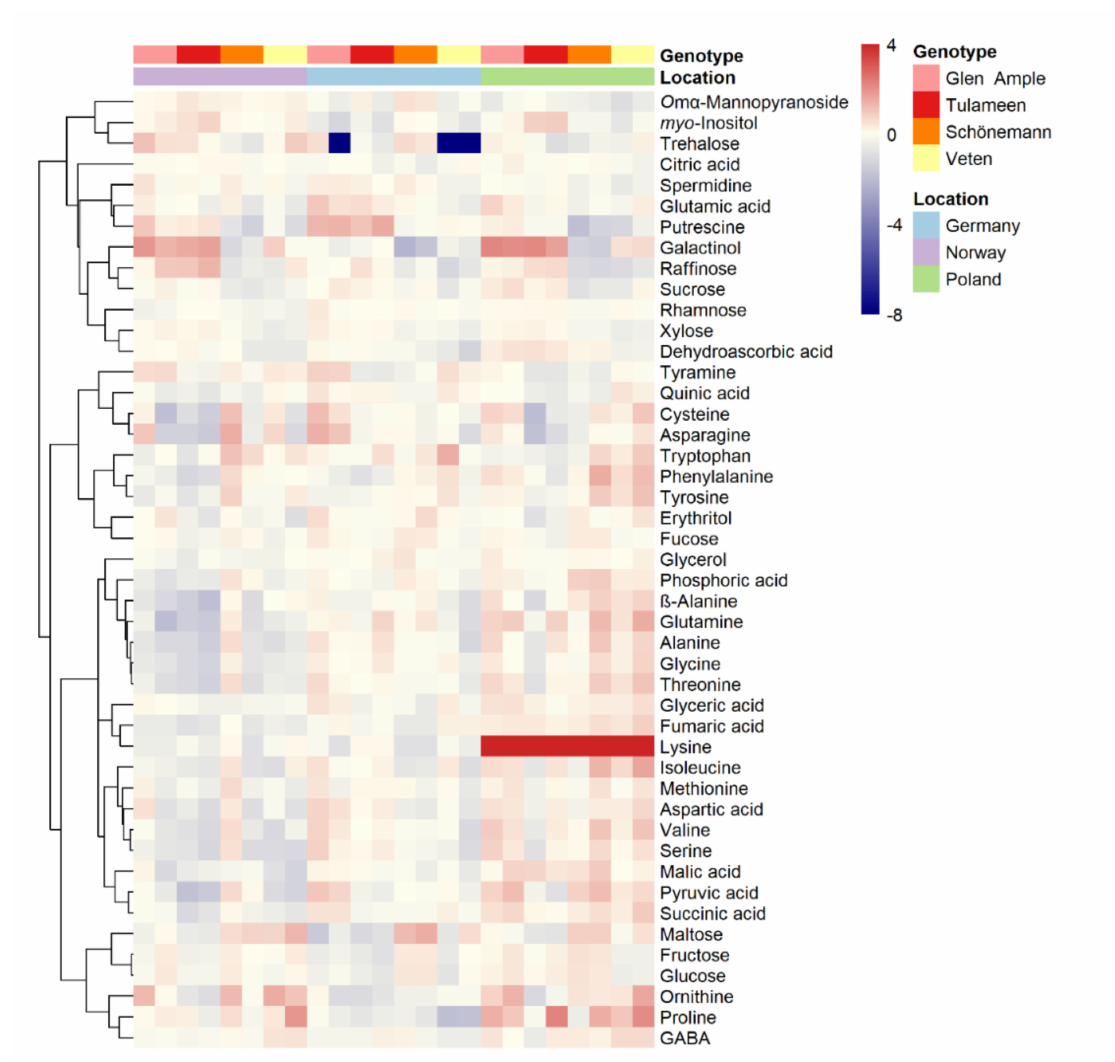
Figure 2. Heatmap visualization of raspberry primary metabolites identified in 2018 in two different harvests. Each value represents the normalized (median-centered and log 10 -transformed) mean of three biological replicates, with red and blue colors denoting relatively high and low intensities. Metabolites are clustered based upon Pearson correlation coefficients. Samples’ location and genotype are indicated with color